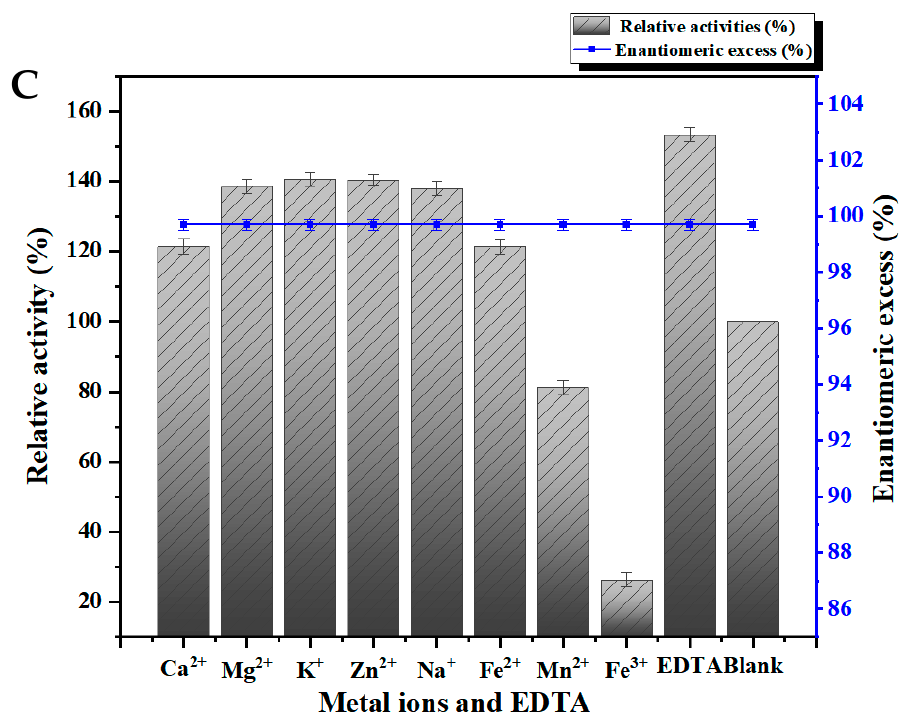
Figure 3. Effects of pH ( A ), temperature ( B ), metal ions and reagents ( C ) on the enzyme activity of the purified ATA117 expressed by the E. coli BL21(DE3)/pETDuet-ATA117 recombinant engineering bacteria. (A total of 2 mL of reaction system: substrate 166.6 mM, IPA 832.8 mM, PLP 1 mM, 15% DMSO, 2.7 U of transaminase pure enzyme aqueous solution, buffer to make up 2 mL volume.)